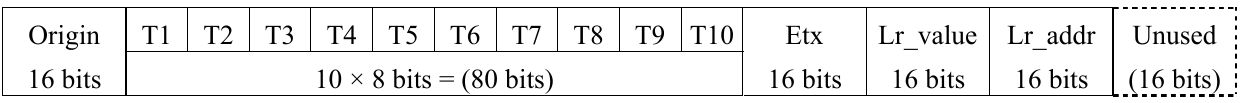
Figure 13. Readings packet length (version